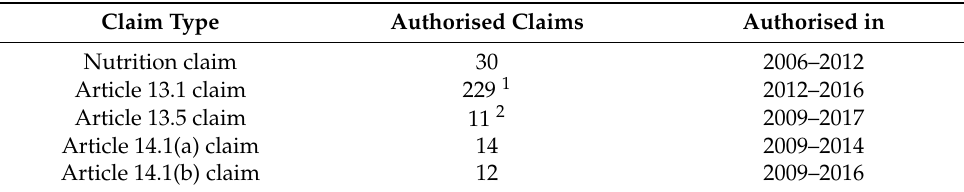
Table 1. Authorised nutrition and health claims in the